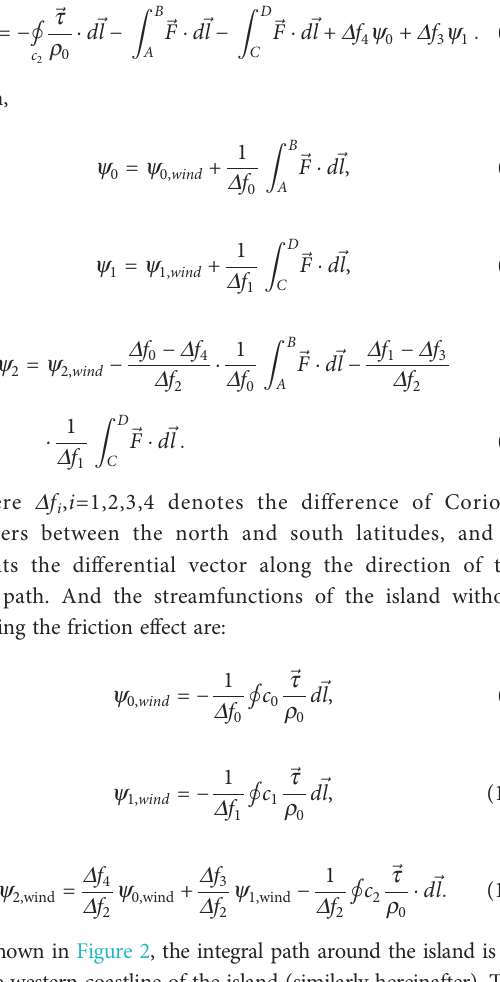
represent streamfunctions when omitting the friction term, the path of the integral curve C 0 is speci fi ed by FBGHF, the path of the integral curve C 1 is represented by IJDCBFI, the path of the integral curve C 2 is denoted by IJEKLABFI, and the curves AB, CB, and DE stand for the RHS boundaries of the island channel.